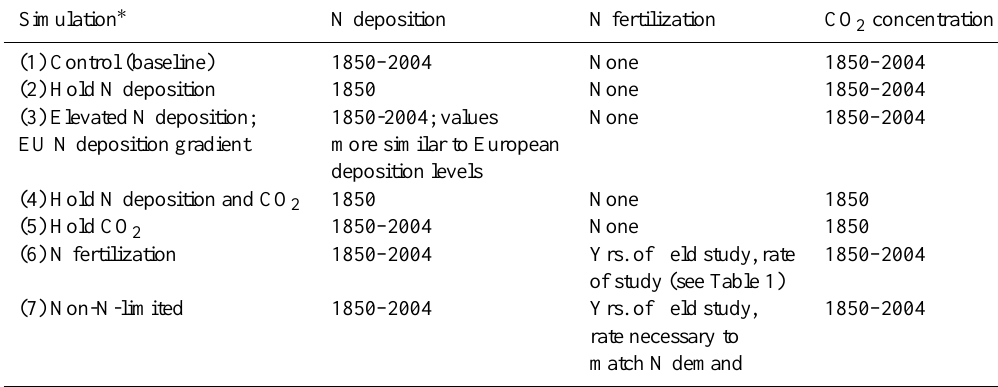
Table 2. Description of simulations and years of driver data used in each